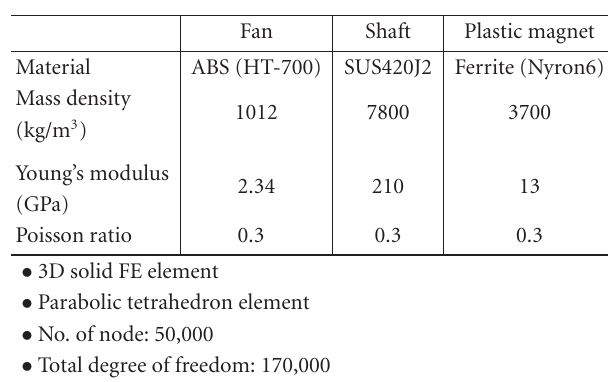
Table 2: Material property and mesh data for FEA.